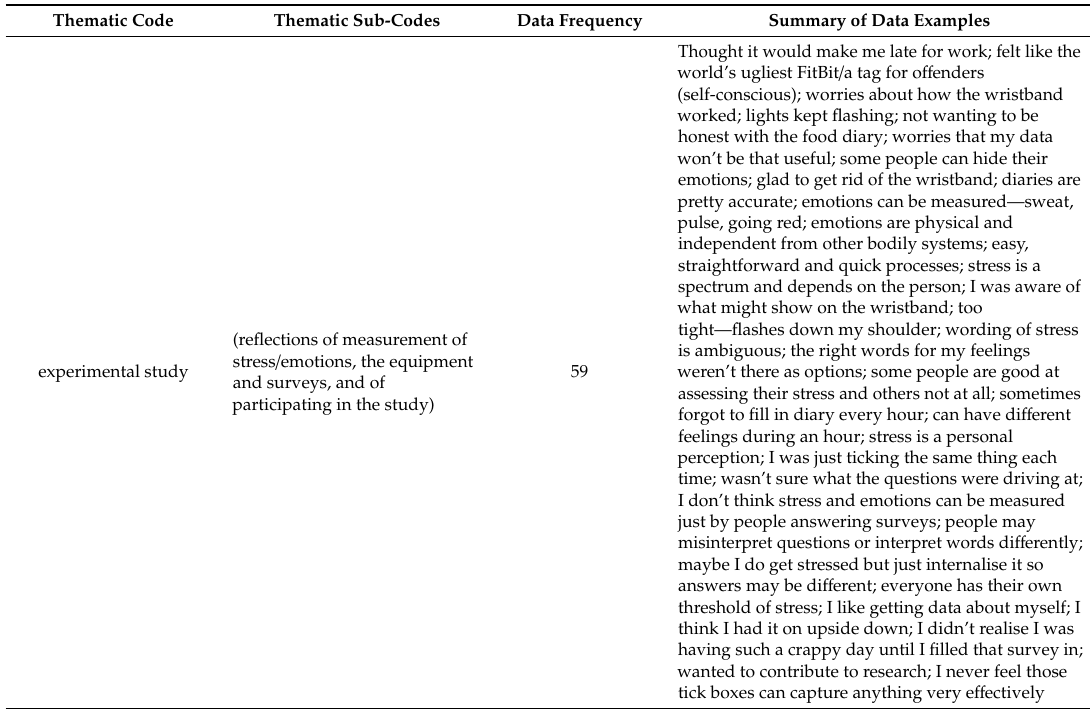
Figure 4. Percentage of participants characterized as “stressed” during journeys and working hours in Salzburg: Physiological measurements (biodata) vs. Interview data vs. eDiary entries. Table 5. Coding framework and examples from qualitative interview data.